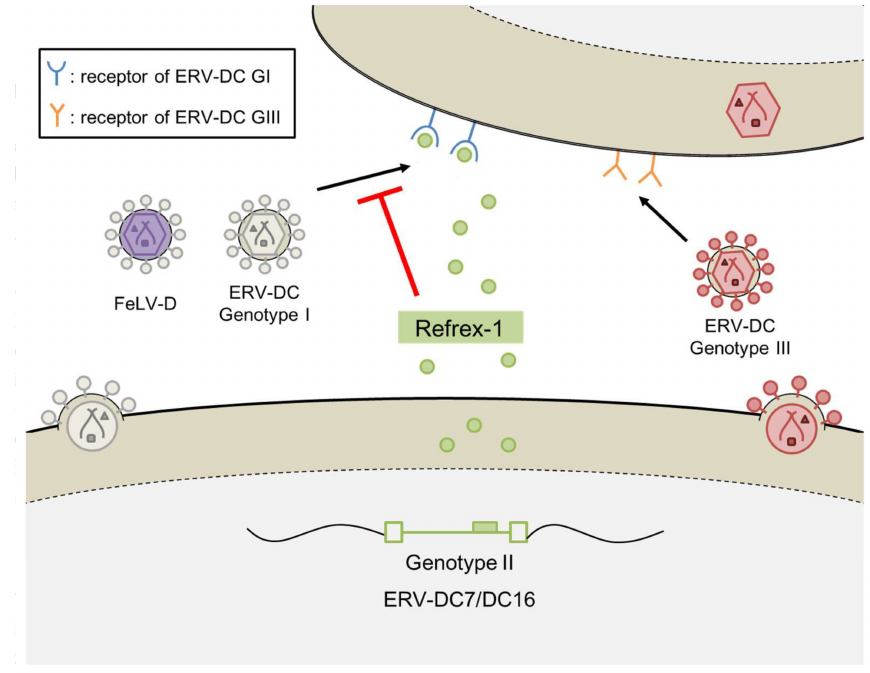
Figure 3. Defense mechanism of